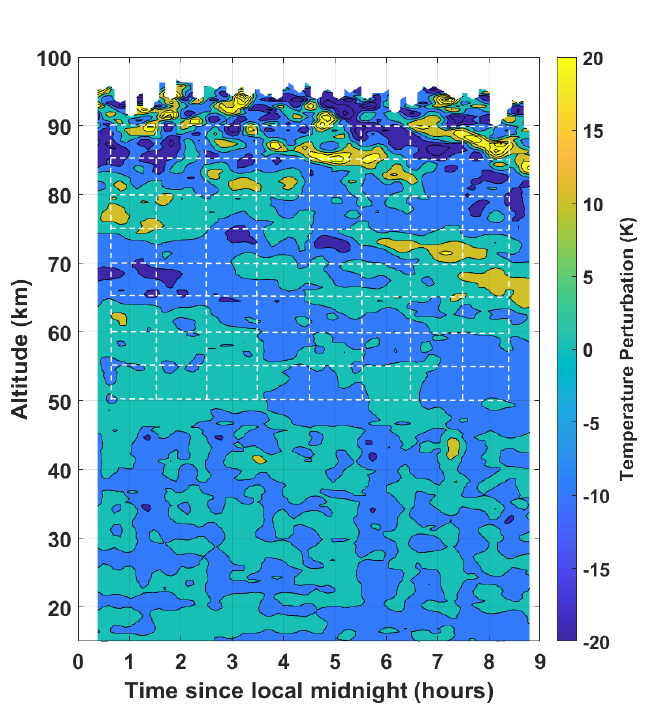
Figure 9. Monge lidar temperature perturbations and analysis grid for the night of D+0.